Question: Briefly state, in one sentence, what is plotted here.
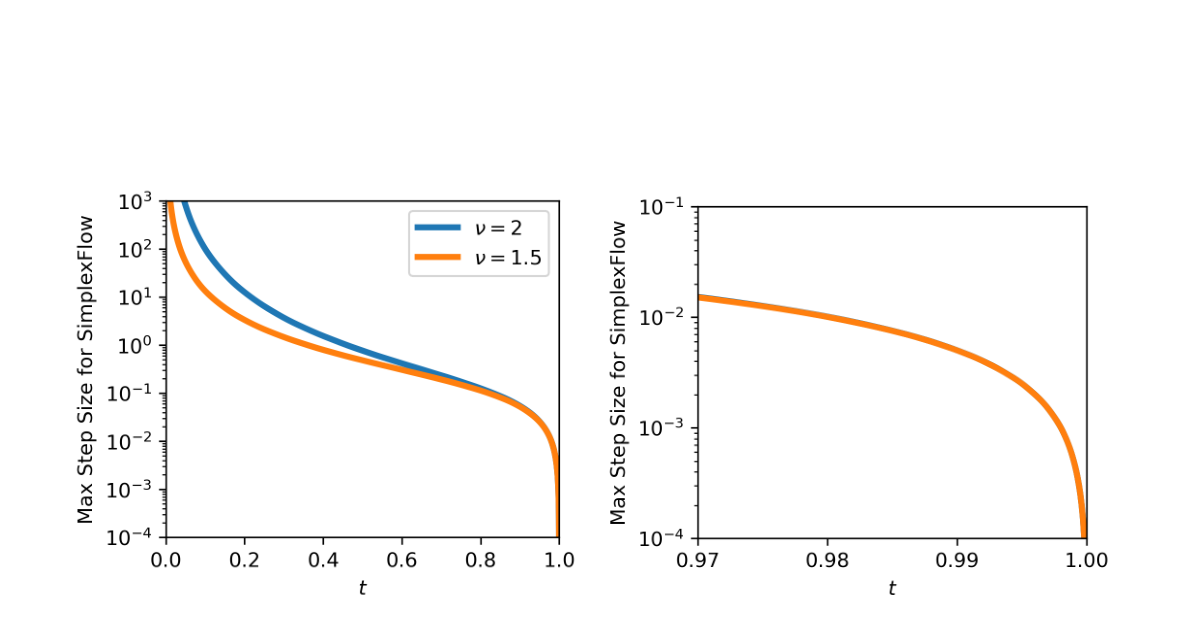
Answer: Left: maximum integration step size to remain on the simplex for a cosine interpolant. Right: zoomed in view of the asymptotic decline of the maximum step size as t →1